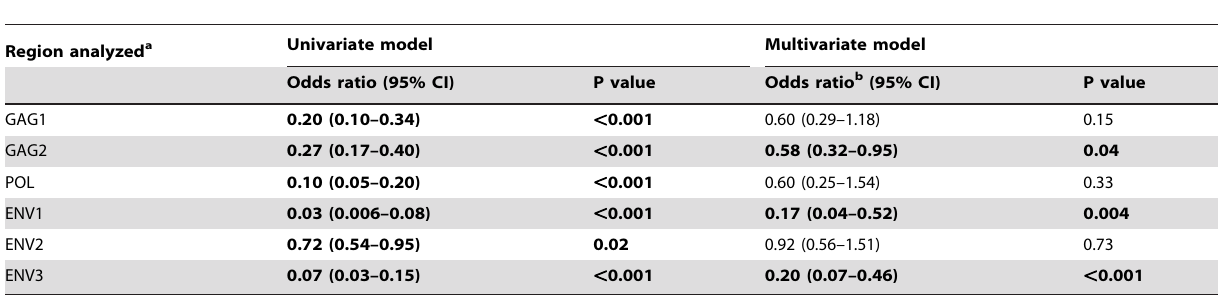
Table 2. Comparison of HRM scores from adults with recent vs. non-recent HIV infection*.